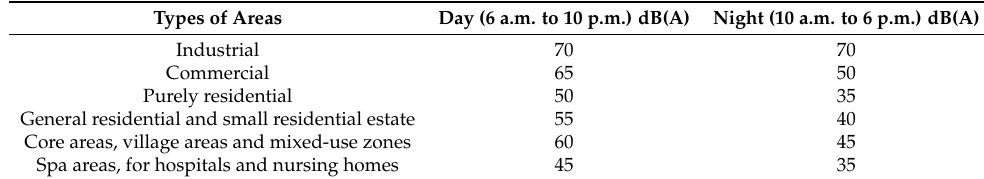
Table 1. Wind turbine noise threshold limits in Germany [9]. Types of